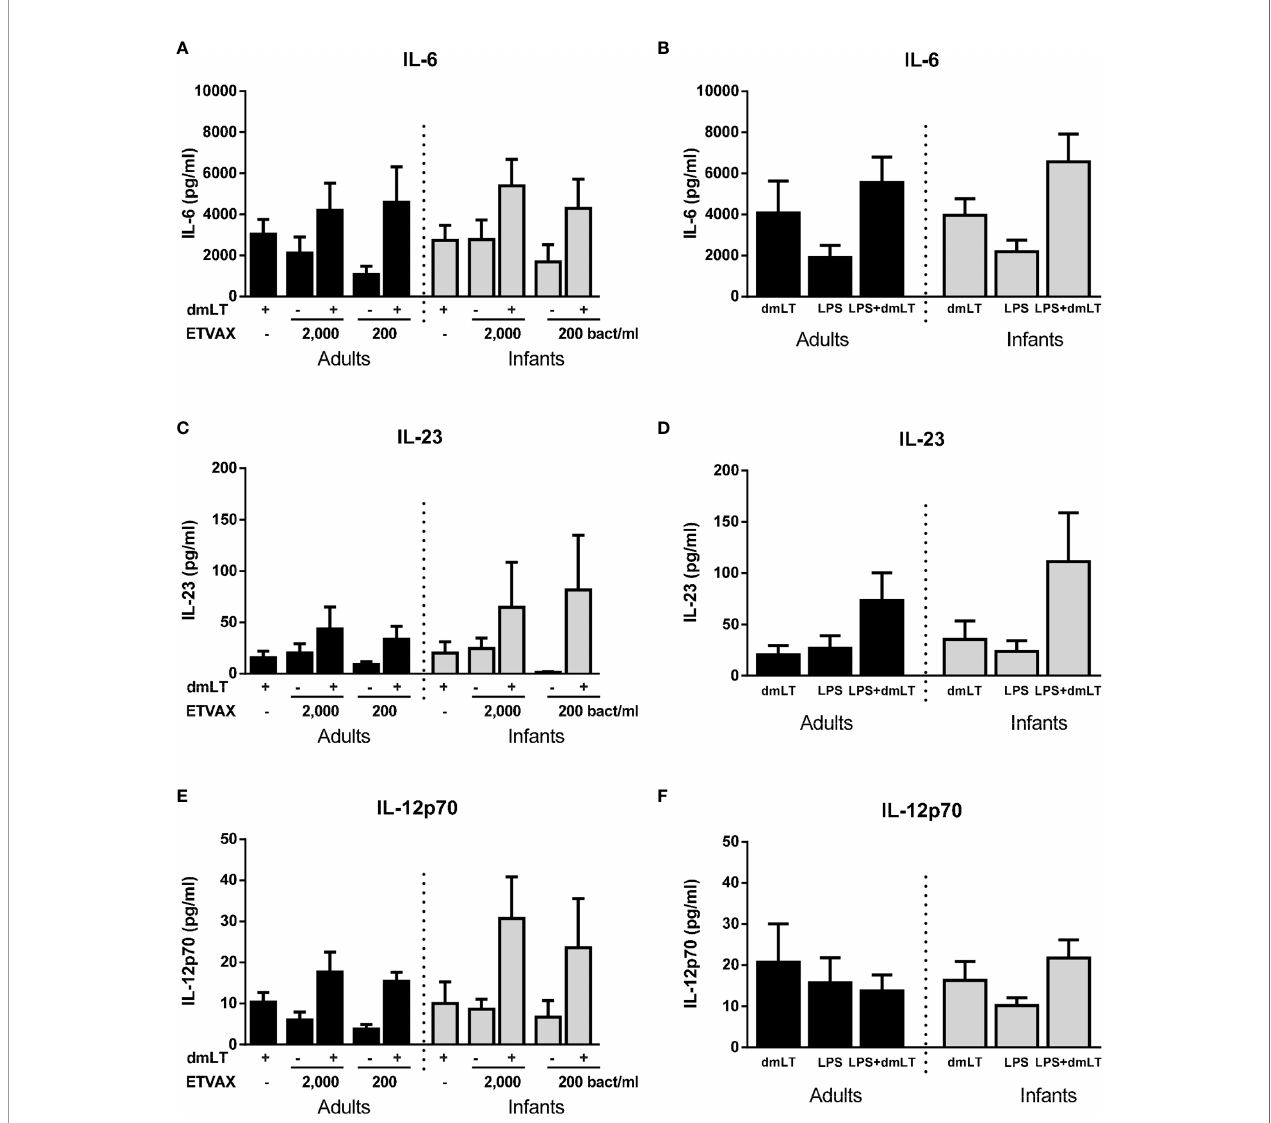
FIGURE 9 | Production of IL-6, IL-23 and IL-12p70 from PBMCs stimulated with ETVAX WCC ± dmLT. (A, B) IL-6, (C, D) IL-23 and (E, F) IL-12p70 concentrations in cultures with PBMCs from adults (n = 5) and infants (n = 5) stimulated with ETVAX WCC (200 or 2000 bacteria/ml) or ETEC O78LPS (0.01 ng/ml) alone or with 10 µg/ml dmLT. Bars represent mean with SEM of cytokine concentrations in culture